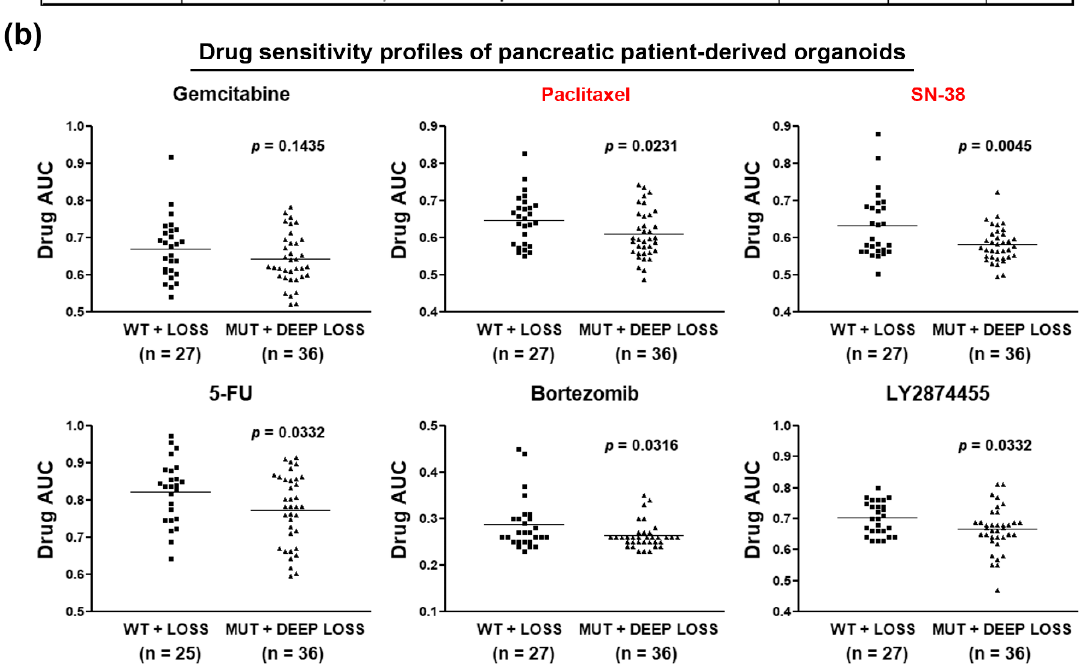
Figure 3. Chemosensitivity profiles in CDKN2A-inactivated PDAC cell lines and patient-derived organoids. ( a ) The correlation between CDKN2A gene copy numbers and drug sensitivities in PDAC cell lines were obtained from the CTRP data via the CellMinerCDB website. Sensitive drugs correlated with low CDKN2A gene copy numbers are shown; ( b ) drug response data in PDAC patient-derived organoids were obtained from the supplementary materials in a previous study (reference [23]). Lower area under the curve (AUC) values indicated that the organoids were more sensitive to drug